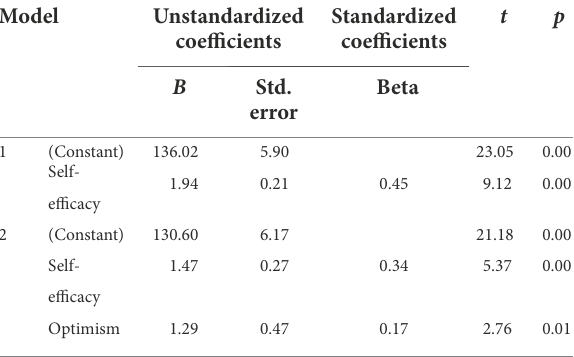
TABLE 8 Humanistic care ability stepwise multiple regression analysis.